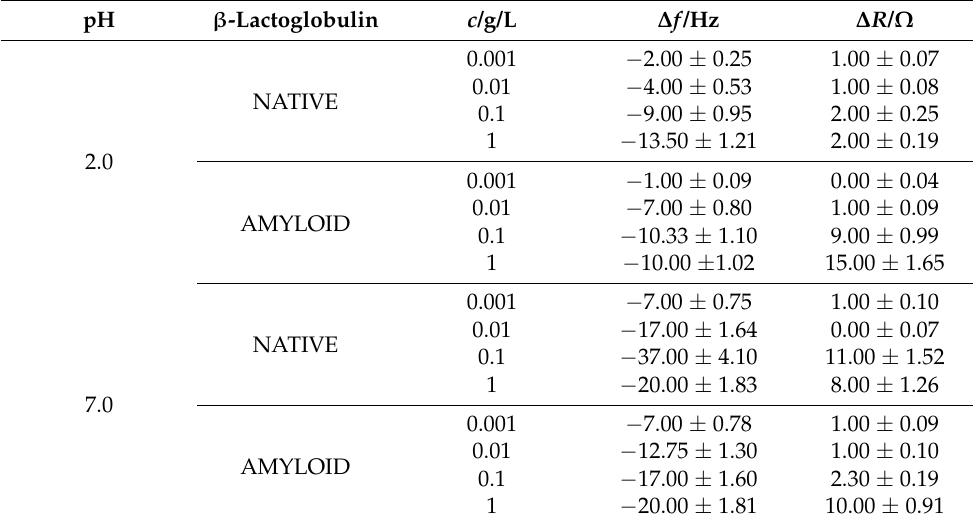
Table 3. Frequency change ( ∆ f ) and resistance change ( ∆ R ) determined by QCM measurement during adsorption of β -lactoglobulin at various concentrations and pHs.